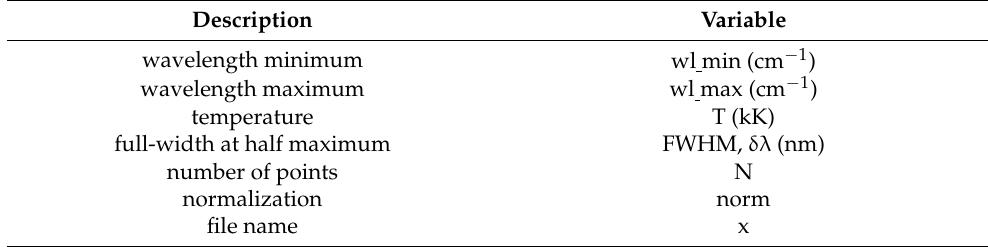
Table 4. Parameters and variables in BESP.m and